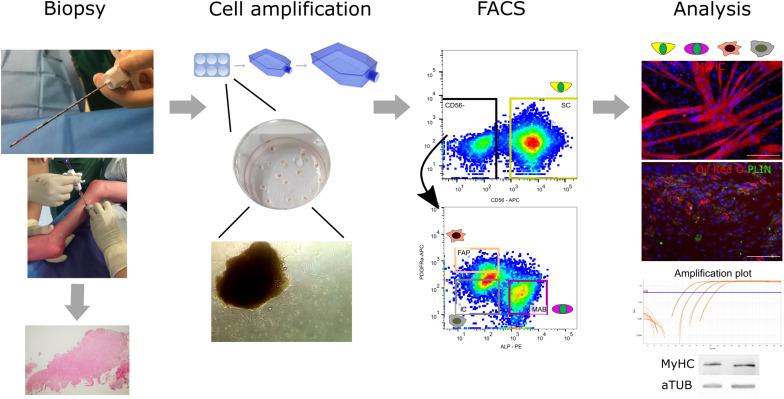
Flowchart from muscle microbiopsy collection to cellular analyses. From left to right: the muscle microbiopsies were collected from the Medial Gastrocnemius under ultrasound guidance from both TD children and patients with CP. Microbiopsies were either cut and histologically assessed or minced and cultured on collagen-coated plates to isolate extruding cells able to proliferate further. After amplification of the cells, a first fluorescent activated cell sorting (FACS) at passage 3–4 was performed based on CD56, a commonly accepted marker for satellite cell (SC)-derived progenitors. Subsequently, around passage 6–8, the CD56– population underwent a second FACS based on markers from literature ALP and PDGFRa for isolation of mesoangioblasts (MABs) and fibro-adipogenic progenitor cells (FAPs), respectively. Together with the CD56– ALP– PDGFRa– population (ICs), all obtained cell types were assessed for their differentiation potential and harvested for immunofluorescence, RT-qPCR and western blot analysis (MyHC, MYOSIN HEAVY CHAIN; PLIN, PERILIPIN; aTUB, α TUBULIN).